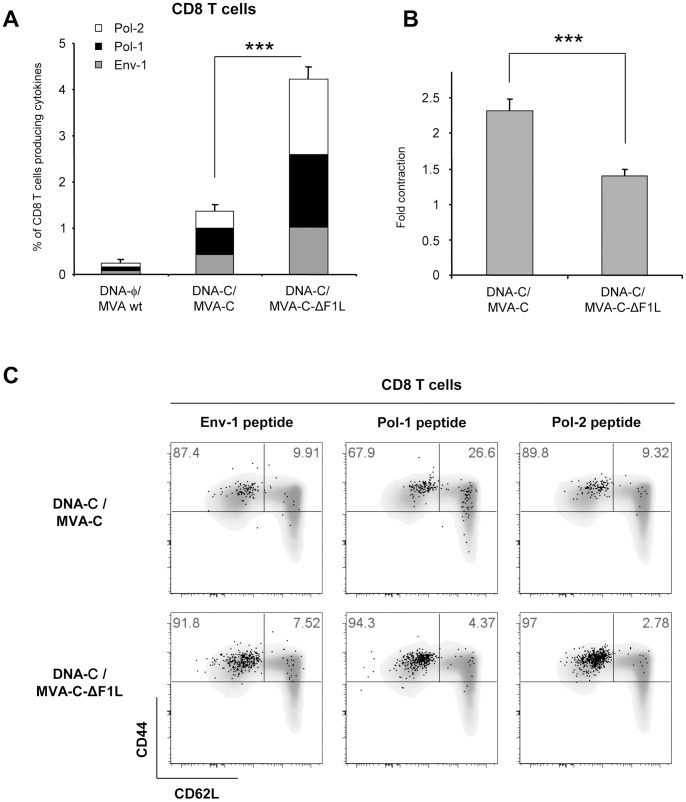
Memory response to HIV-1 peptides elicited by F1L deletion mutant.(A) Magnitude of vaccine-specific CD8 T cells. The HIV-1-specific CD8 T cells were measured 53 days after the last immunization by ICS assay following stimulation with the different HIV-1 peptides in the 3 mice left in each group (n = 3). The values represent the sum of the percentages of positive T cells secreting IFN-γ and/or IL-2 and/or TNF-α against Env-1+Pol-1+Pol-2 peptides. All data are background-subtracted. (B) Fold contraction of the frequency of HIV-1-specific CD8 T cells following boost. Fold contraction was calculated as a ratio of HIV-1-positive T cells at days 10 and 53 post boost. (C) Phenotypic profile of memory HIV-1-specific CD8 T cells. Representative FACS plots showing the percentage of Env-1, Pol-1 or Pol-2-specific CD8 T cells with central memory (TCM, CD44highCD62L+) or effector memory (TEM, CD44highCD62L−) phenotype. *** p<0.001. p values indicate significantly higher response (A) or lower fold contraction (B) compared to DNA-C/MVA-C immunization group.